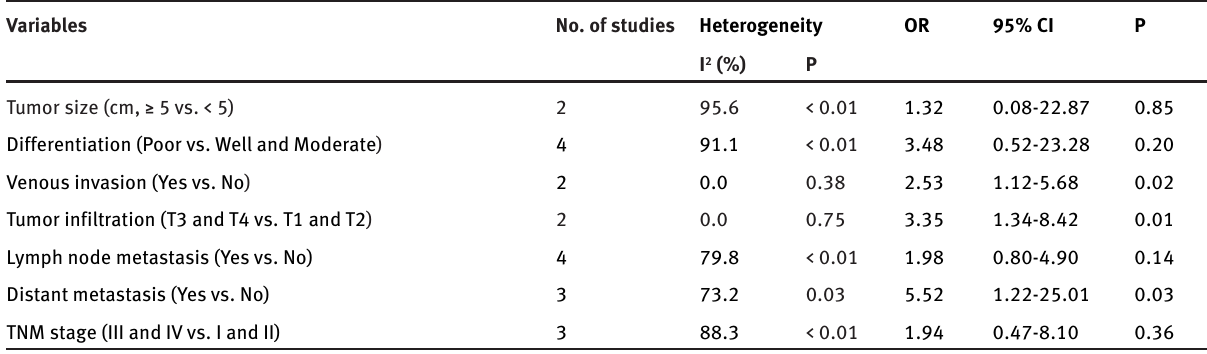
Table 3: Relationship between HOTAIR expression and clinicopathological variables in CRC. Variables